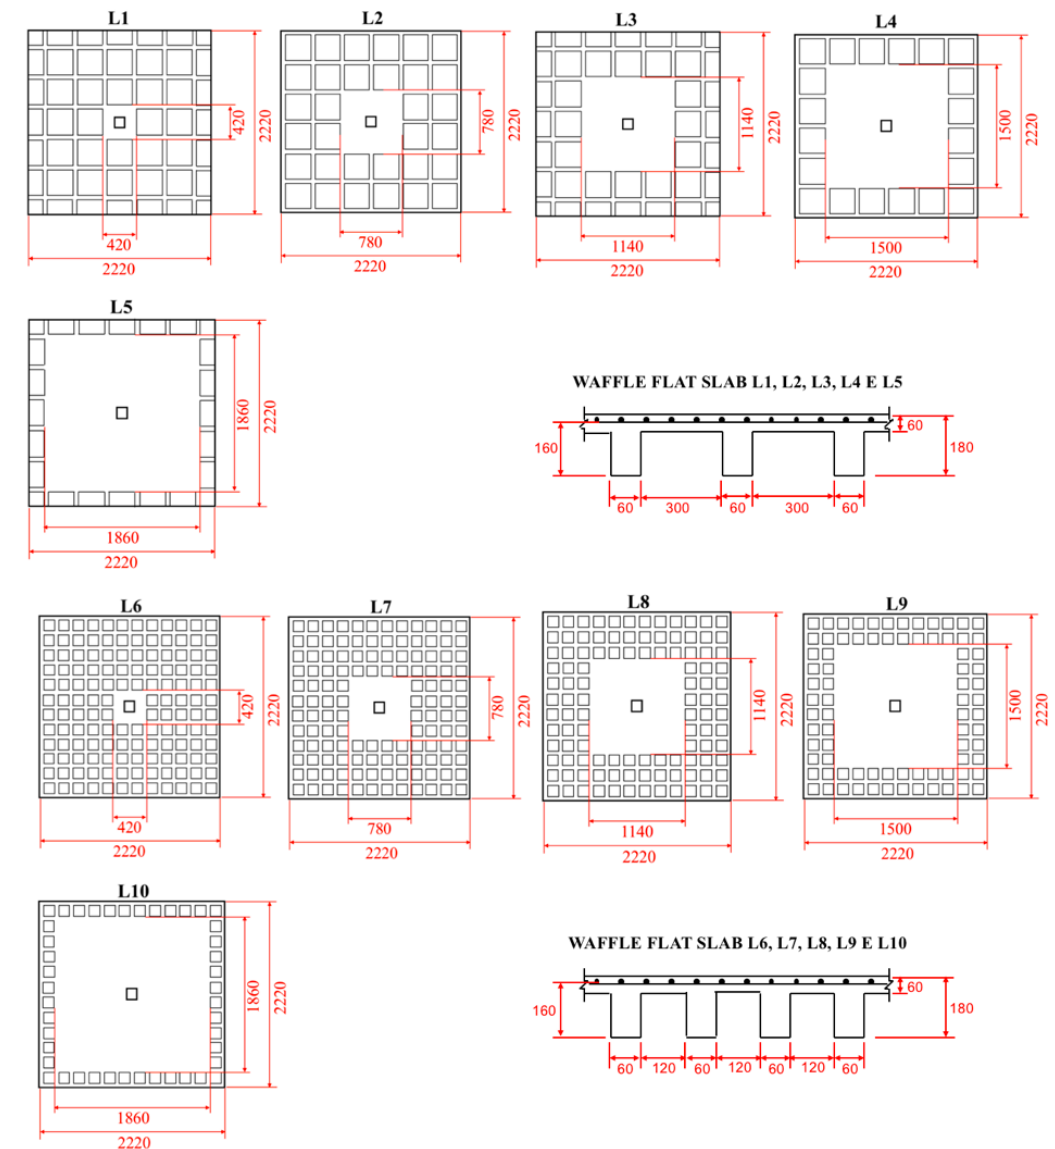
Figure 4. Waffle flat slabs (units in